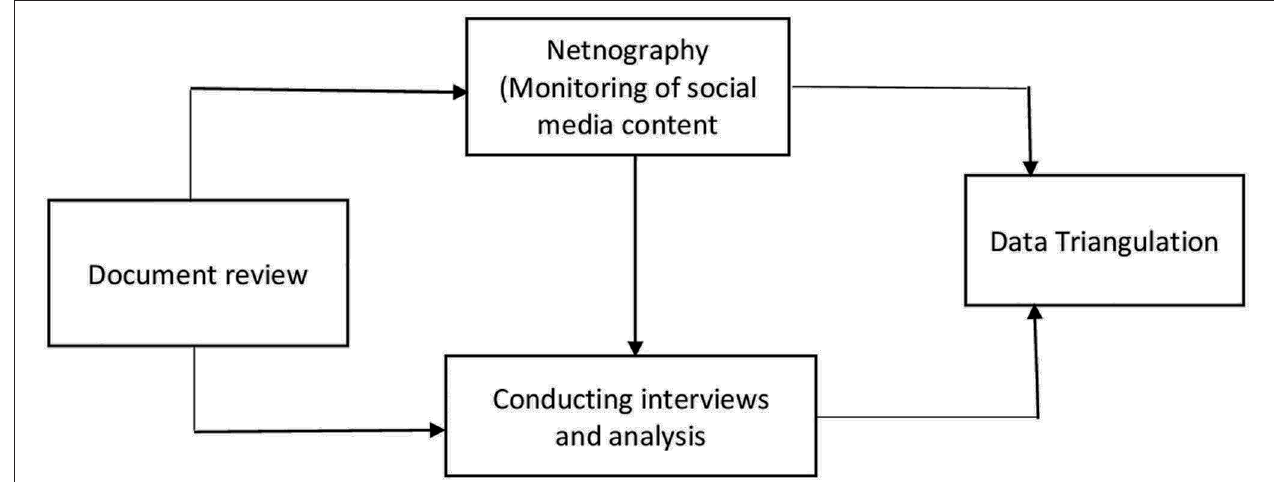
FIGURE 1 | Pathway for conducting the study on myths and misconceptions on COVID-19 in Ghana,